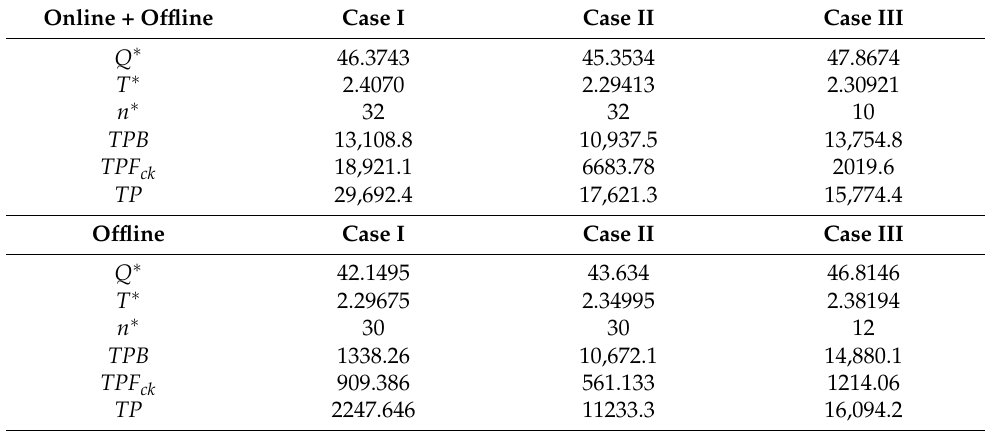
Table 3. Computation results of Example 1. for online and offline.